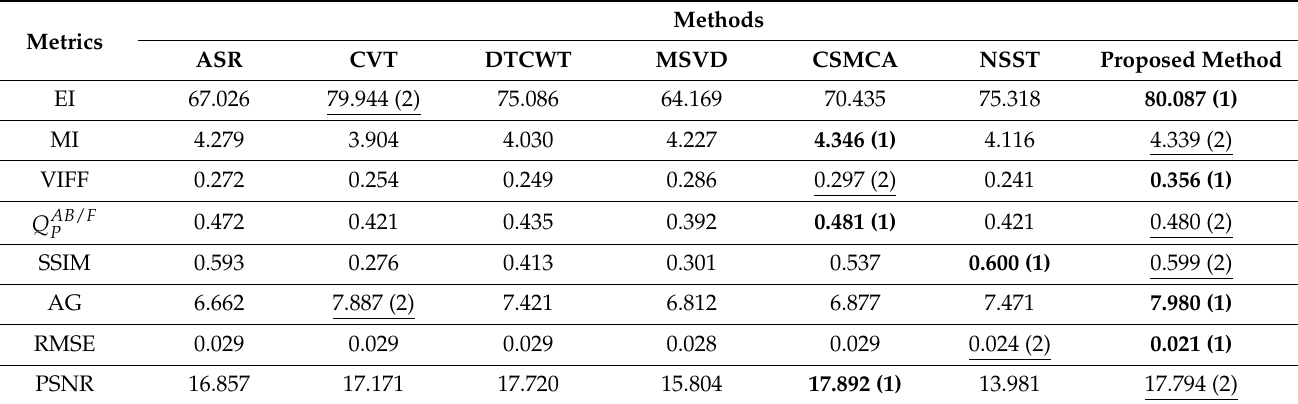
Table 4. Quantitative analysis of the various fusion methods for MRI-CT (set-11).